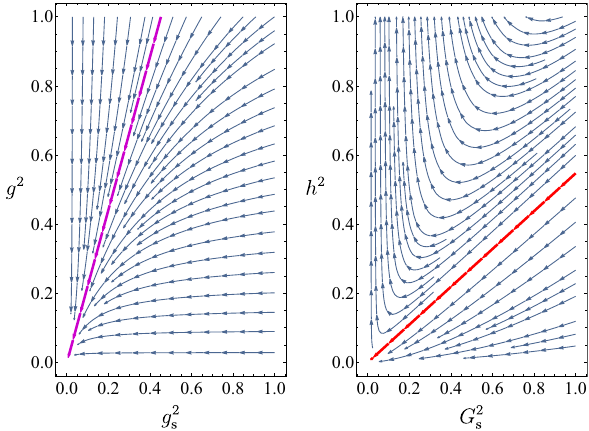
Fig. 4 Left Panel : phase diagram and flow of the gauge couplings in the h 2 = 0 plane. Both couplings exhibit an AF flow to the Gaußian FP in the UV, being attracted by the trajectory where g 2 = ˆ g 2 ∗ g 2 s (magenta line). Right Panel : phase diagram and coupling flow using the rotated gauge coupling G s (parametrizing the magenta-line trajectory of the left panel). AF trajectories require a sufficiently small initial Yukawa ≤ (cid:15) withtheupperbound onthecriticalsurface (cid:15) denoted coupling h 2 0 by the red line. The latter represents the special trajectory satisfying Eq.